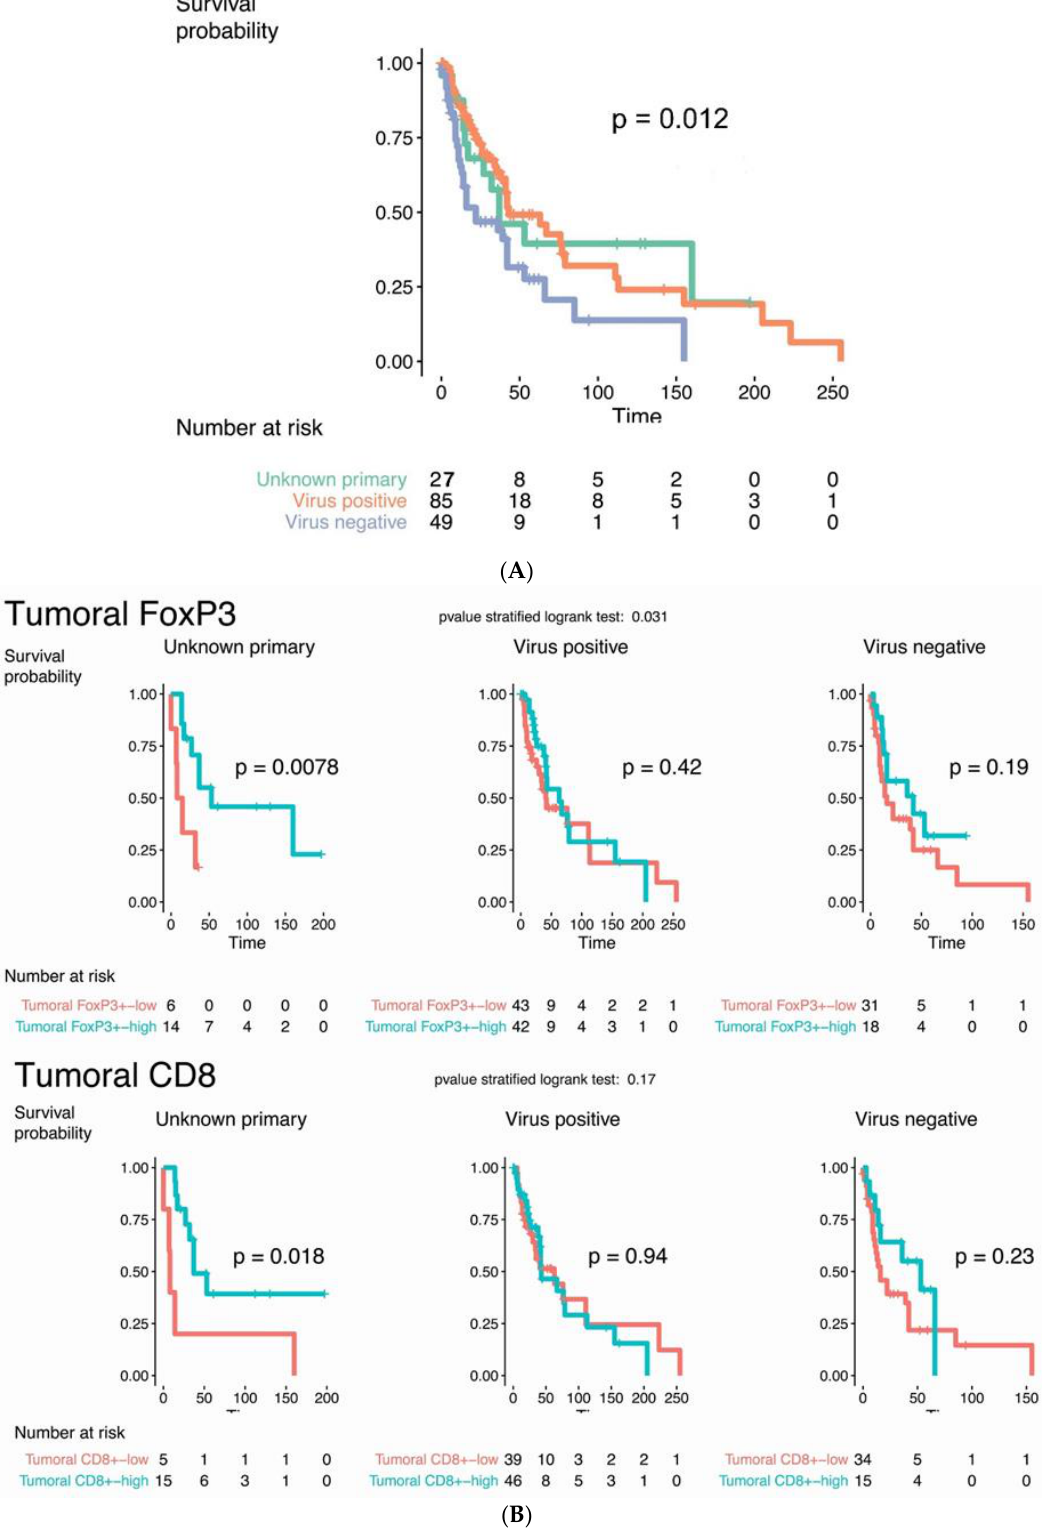
Figure 1. ( A ) Kaplan–Meier curves of overall survival in the three groups ( p = 0.016). ( B ) Kaplan–Meier curves demonstrate better overall survival in Merkel cell carcinoma of unknown primary with high intratumoral FoxP3+ ( p = 0.0078) and high intratumoral CD8+ ( p = 0.018) infiltrates. Significant correlations were not seen in the virus-positive and virus-negative groups of known